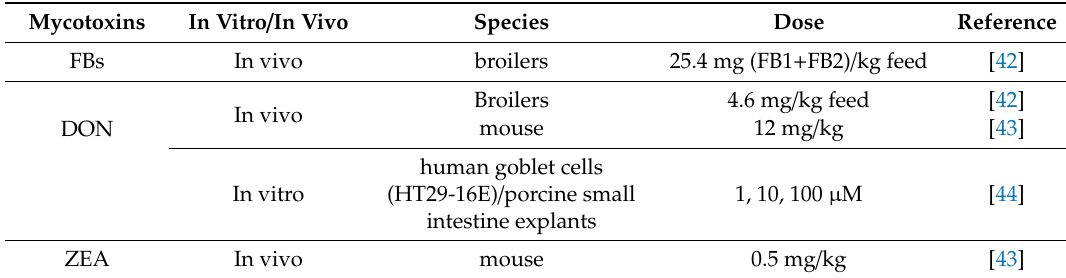
Table 3. In vitro and in vivo studies on the e ff ects of di ff erent mycotoxins on intestinal mucosal chemical barriers in di ff erent